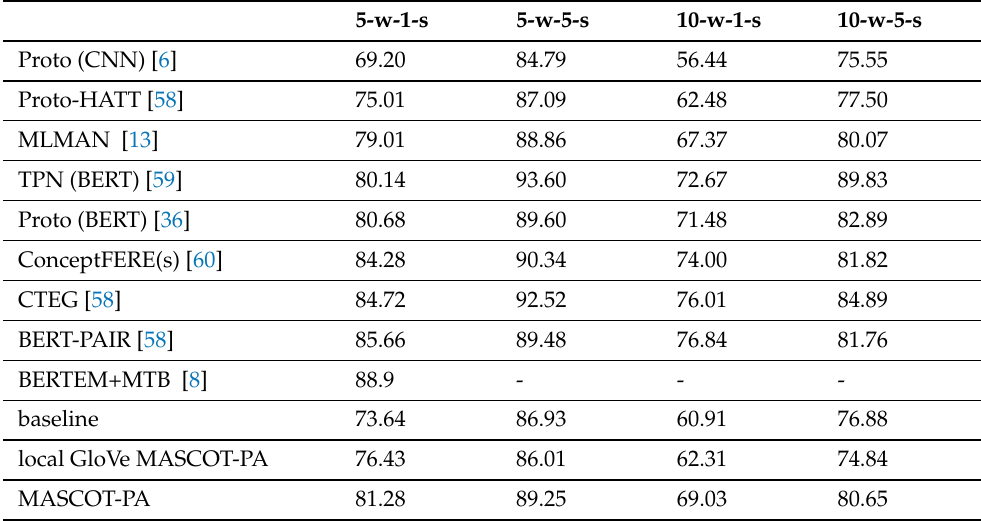
Table 6. Overall result for the FewRel 1.0 task, where N -w- K -s represent the N -way- K -shot task performance.